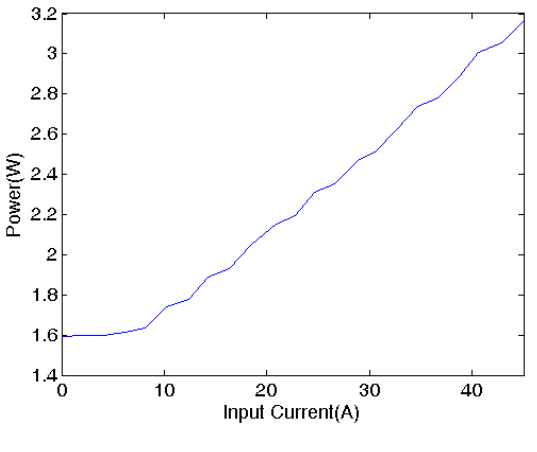
Figure 15. Power consumption vs. the input current of the improved